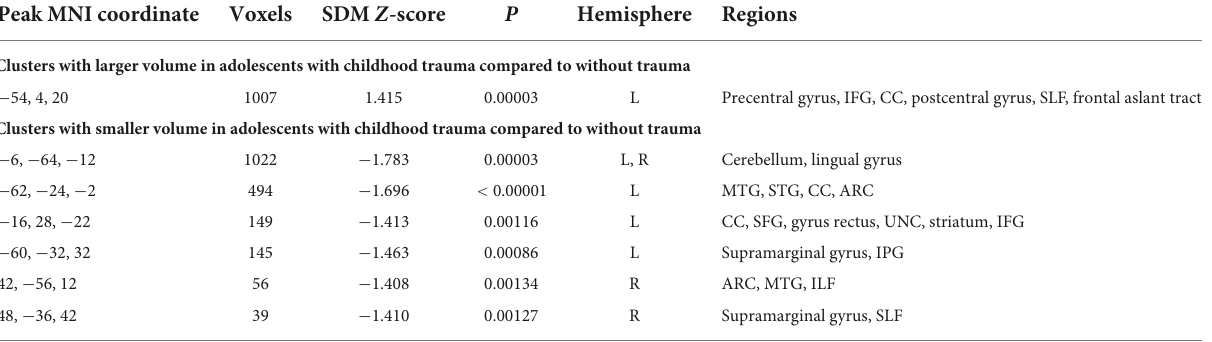
TABLE 2 Results of whole brain voxel-based morphometry (VBM) meta-analysis of childhood trauma in adolescents. Peak MNI coordinate Voxels SDM Z -score P Hemisphere